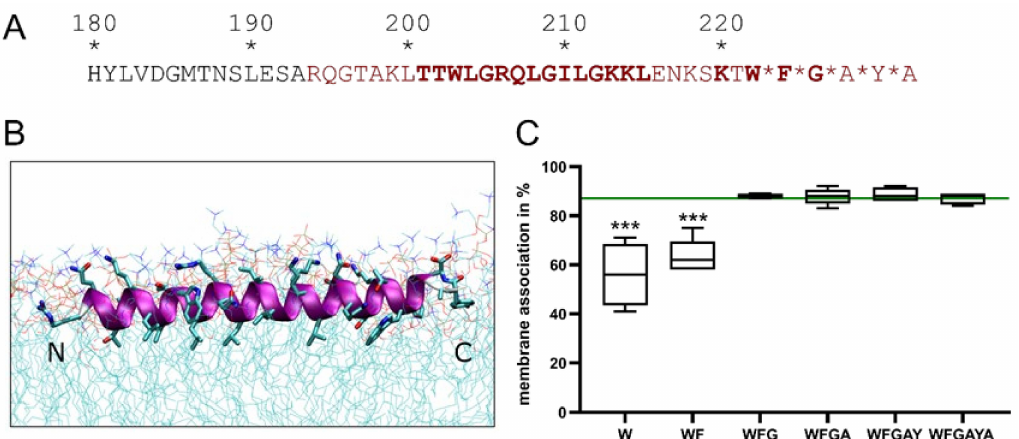
Figure 1. Features of the E rns membrane anchor. ( A ) shows the carboxy-terminal sequence of E rns from BVDV CP7. Amino acids in bold are those that were found to have no water accessibility in peptides in bicelles. Colored in red is the sequence that was used for the molecular dynamics simulation leading to the membrane anchor model shown in ( B ). The simulation was done for E rns residues Arg194 to Ala227 at 72 ns in an explicit DMPC membrane. The protein shows a strong helical fold and lies slightly inclined in the hydrophobic region of the membrane just beneath the lipid head groups (see [16] for further information). Location of N and C terminus are indicated. ( C ) Percentage of E rns that is membrane associated. Recombinantly expressed E rns mutants that were successively shorted by a single amino acid from the carboxy-terminus (see stars that indicate the different stop sites in ( A ) were analyzed for their membrane association). Asterisks denote significant differences from the wt protein as tested with one-way ANOVA and a Dunnett’s post-hoc test with three stars representing p ≤ 0.001. Already the loss of four amino acids from the carboxy-terminus leads to a significant loss of membrane